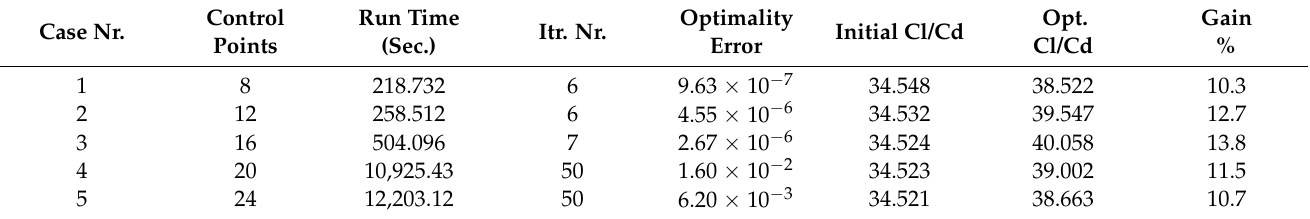
Figure 5. Optimality of the optimization process, ( A ) cases 1, 2, 3, ( B ) 4, and 5. Table 3. Comparison of the optimization results for five cases.